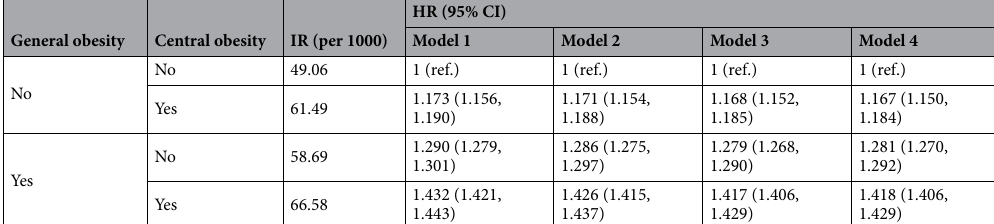
Risk of knee OA according to changes in obesity status.